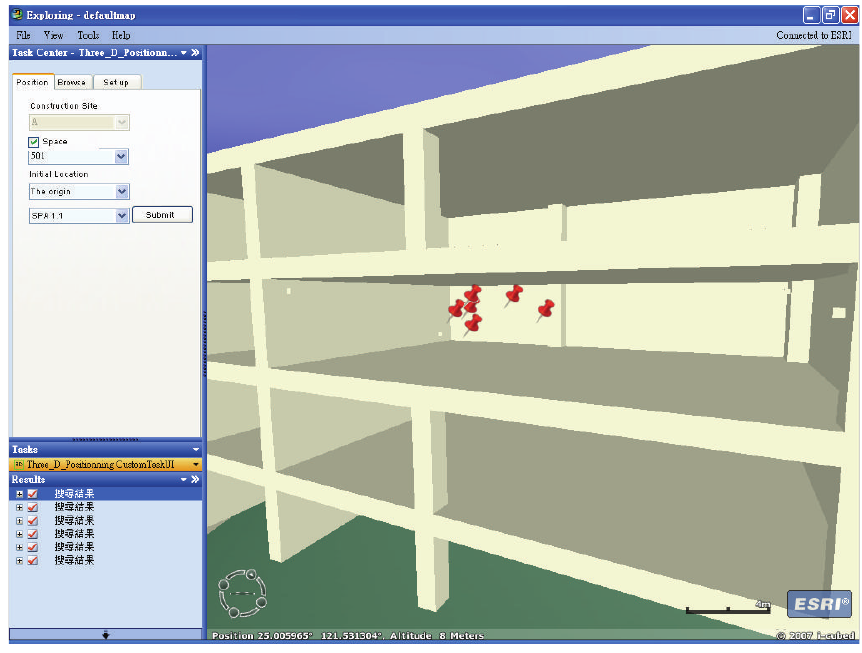
Figure 12: Target object location display.